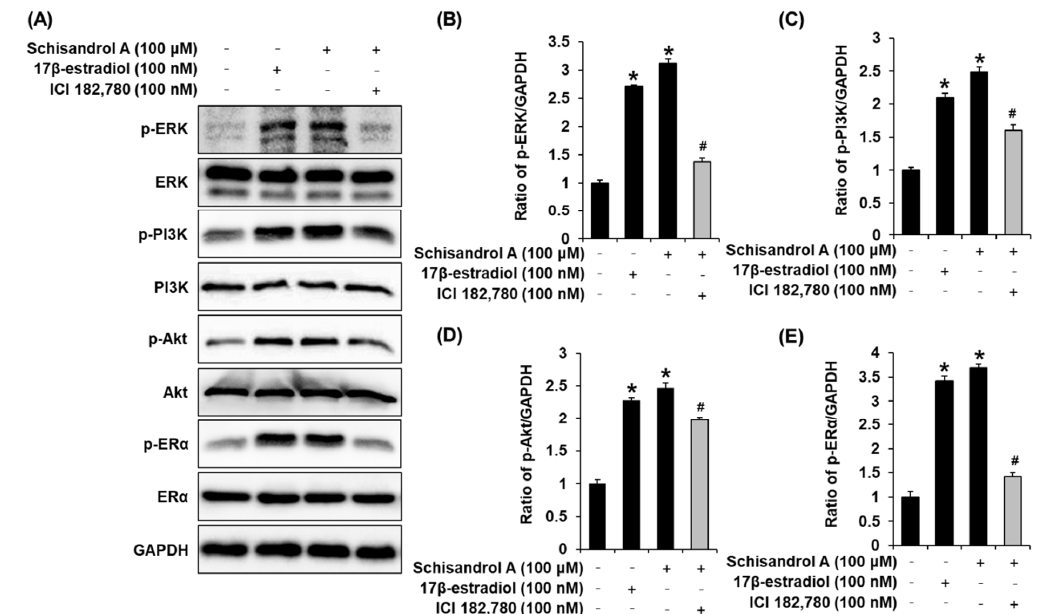
Figure 4. Effect of schisandrol A and 17 β -estradiol (E2) on the absence or presence of ICI 182,780 (ICI) in the protein expression of phospho-extracellular signal-regulated kinase (p-ERK), ERK, phospho-phosphatidylinositol 3-kinase (p- PI3K), PI3K, p-Akt, Akt, phospho-estrogen receptor α (p-ER α ), and ER α in MCF-7 cells: ( A ) protein expression levels of p-PI3K, PI3K, p-Akt, Akt, p-ER α , and Er α and glyceraldehyde 3-phosphate dehydrogenase (GAPDH) in untreated cells and 50 µM and 100 µM schisandrol A-treated MCF-7 cells (24 h). ( B – E ) Bar graph representing the densitometric quantification of Western blot bands. * Significant difference between cells treated with schisandrol A or E2 and the untreated cells. # Significant reduction in co-treatment with ICI compared to treatment with compounds alone (n = 3 independent experiments, p < 0.05, Kruskal–Wallis nonparametric test). Data are represented as mean ± SEM.